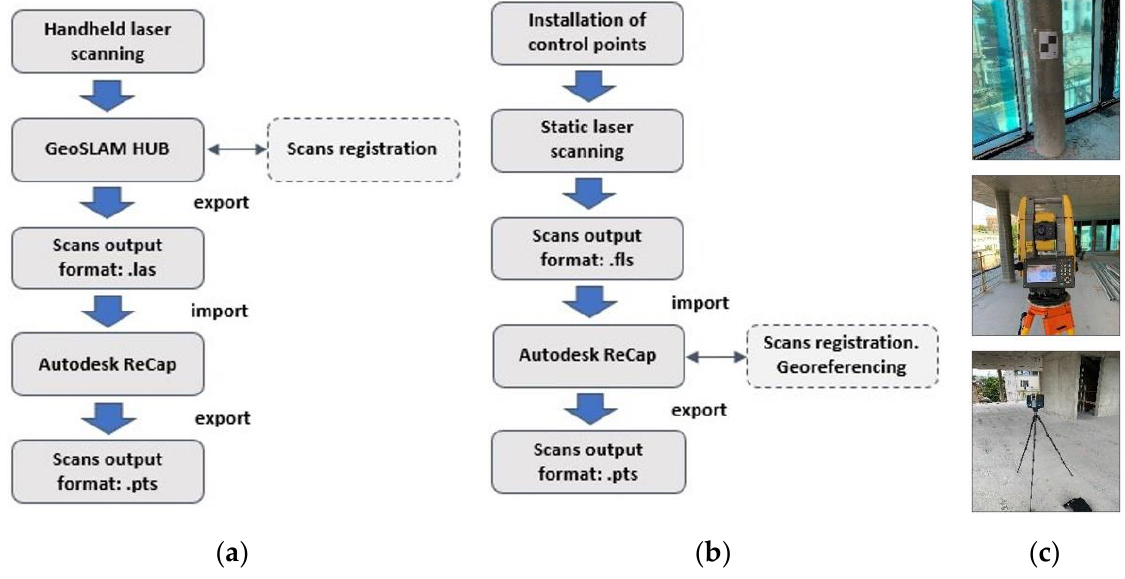
Figure 2. Workflow of data acquisition and pre-processing: ( a ) using a ZEB-GO handheld laser scanner, ( b ) using a FARO Focus S terrestrial laser scanner, and ( c ) example of a control point, TOPCON GT series positioning system, and FARO Focus S laser scanner. Table 2. Main parameters of laser scanners.